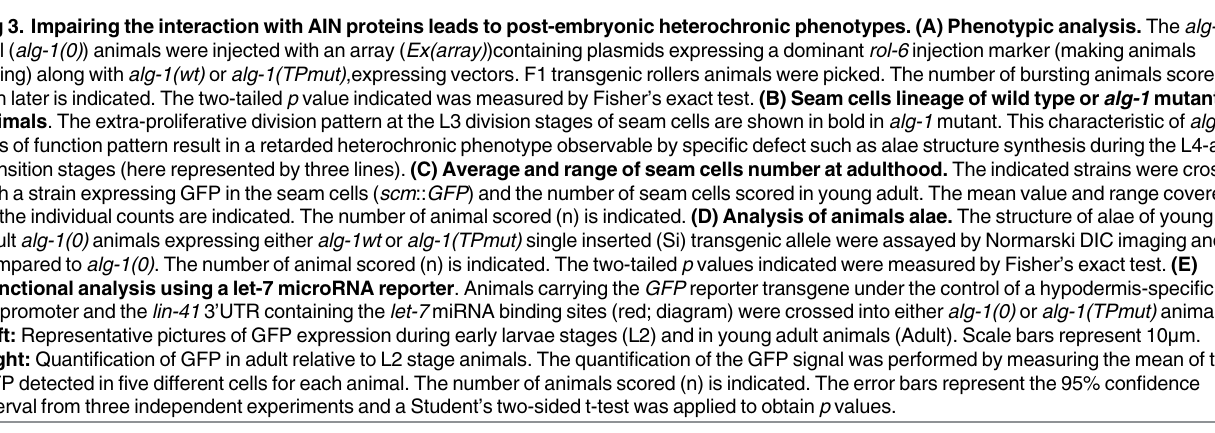
Fig 3. Impairing the interaction with AIN proteins leads to post-embryonic heterochronic phenotypes. (A) Phenotypic analysis. The alg-1 null ( alg-1(0) ) animalswere injected with an array ( Ex(array) )containingplasmidsexpressinga dominant rol-6 injectionmarker (makinganimals rolling)along with alg-1(wt) or alg-1(TPmut) ,expressingvectors. F1 transgenicrollers animalswere picked. The number of bursting animalsscored (n) 48h later is indicated.The two-tailed p value indicatedwas measuredby Fisher’s exact test. (B) Seam cells lineage of wild type or alg-1 mutant animals . The extra-proliferative divisionpattern at the L3 divisionstages of seam cells are shownin boldin alg-1 mutant. This characteristic of alg-1 loss of function pattern result in a retardedheterochronic phenotype observable by specific defect such as alae structure synthesis duringthe L4-adult transition stages (here represented by three lines). (C) Averageand range of seam cells number at adulthood. The indicatedstrains were crossed with a strain expressingGFP in the seam cells ( scm :: GFP ) and the numberof seam cells scored in youngadult. The mean value and range covered by the individualcounts are indicated. The number of animal scored (n) is indicated. (D) Analysis of animals alae. The structure of alae of young adult alg-1(0) animalsexpressingeither alg-1wt or alg-1(TPmut) single inserted (Si) transgenicallele were assayed by Normarski DIC imagingand comparedto alg-1(0) .The numberof animal scored (n) is indicated.The two-tailed p values indicatedwere measuredby Fisher’s exact test. (E) Functional analysis using a let-7 microRNAreporter . Animalscarrying the GFP reporter transgene under the control of a hypodermis-specific col- 10 promoterand the lin-41 3’UTR containing the let-7 miRNA binding sites (red; diagram) were crossed into either alg-1(0) or alg-1(TPmut) animals. Left: Representative pictures of GFP expression during early larvae stages (L2) and in youngadult animals(Adult). Scale bars represent 10 μ m. Right: Quantification of GFP in adult relative to L2 stage animals. The quantification of the GFP signal was performed by measuringthe mean of the GFP detected in five different cells for each animal. The number of animalsscored (n) is indicated.The error bars represent the 95% confidence intervalfrom three independentexperimentsand a Student’stwo-sidedt-test was appliedto obtain p values.